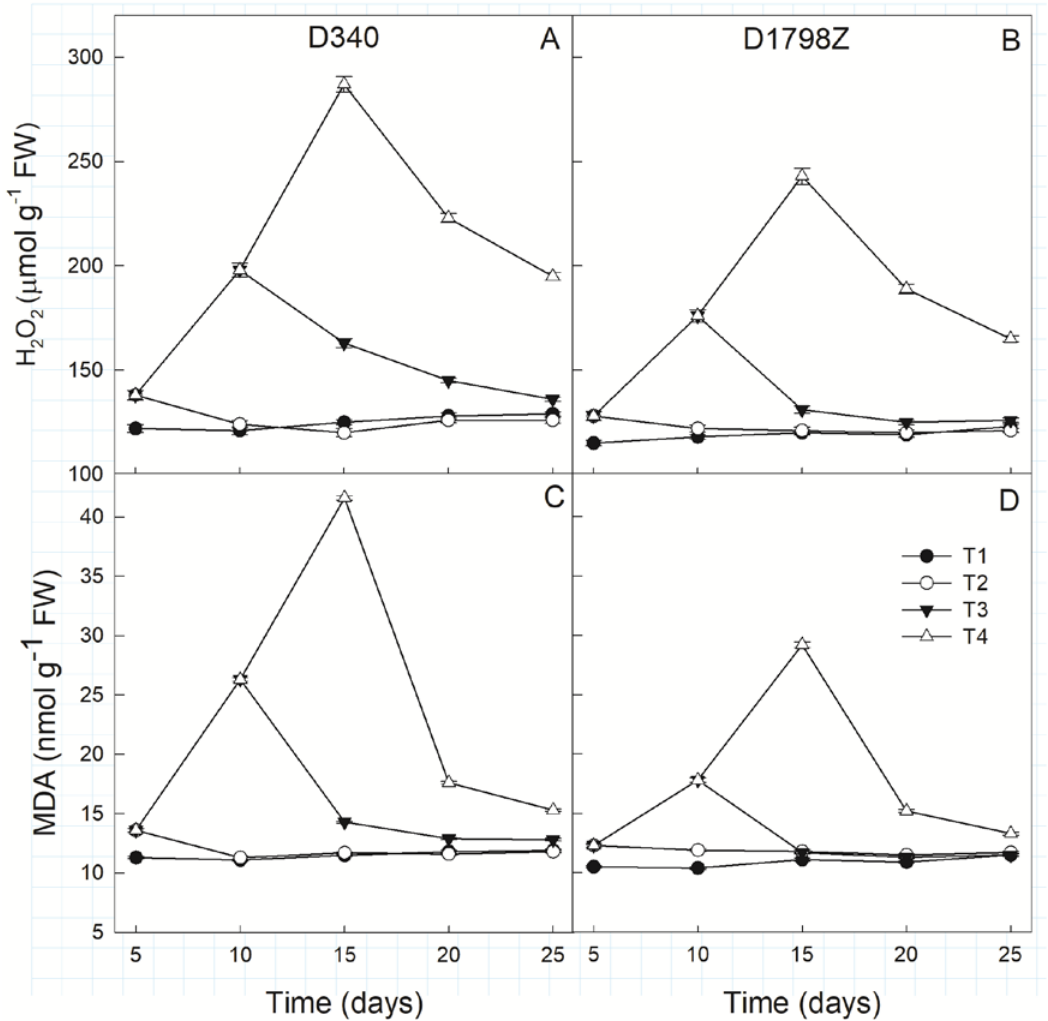
Figure 8. E ff ect of di ff erent drought durations and re-watering on oxidative indicators of two maize Figure 8. Effect of different drought durations and re-watering on oxidative indicators of two maize lines. HO ( A , B ) and MDA, Malondialdehyde ( C , D ) Each parameter is the average of three lines. HO ( A – B ) and MDA, Malondialdehyde ( C – D ) Each parameter is the average of three replicates.